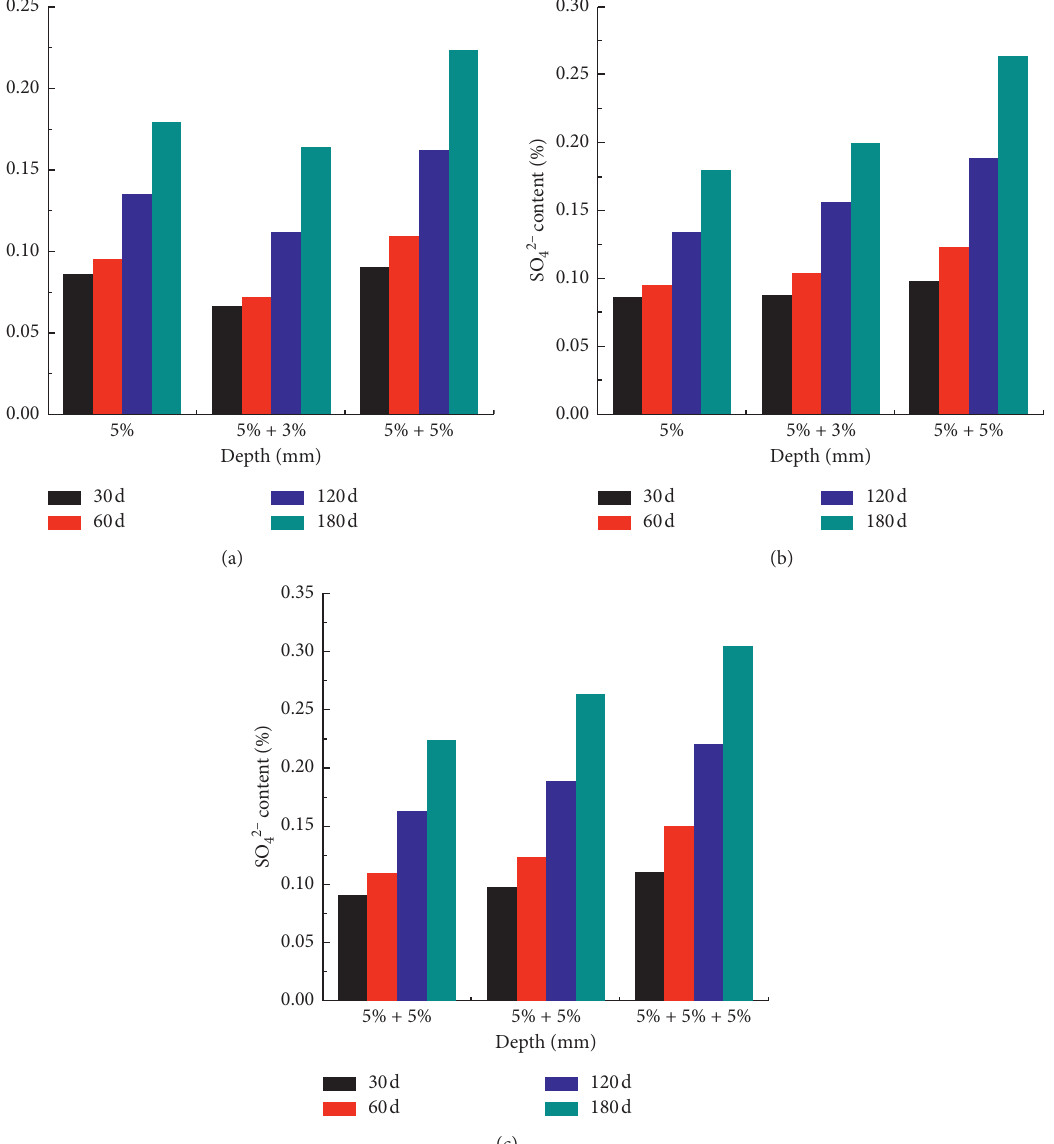
Figure 4: SO 2 − concentration test results at 15mm. (a) Na 2 SO 4 +MgSO 4 , (b) Na 2 SO 4 +NaHCO 3 , and (c) Na 2 SO 4 +5% MgSO 4 +5% NaHCO 3 4